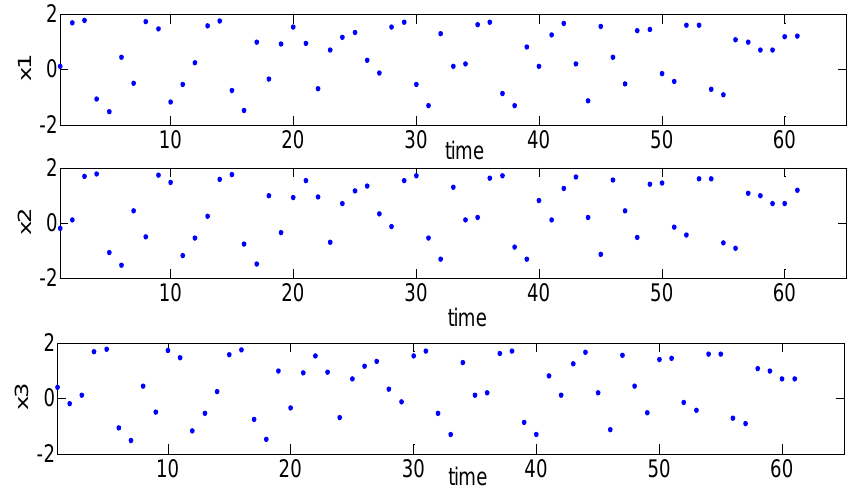
Figure 2. State responses of the original Henon Map system.